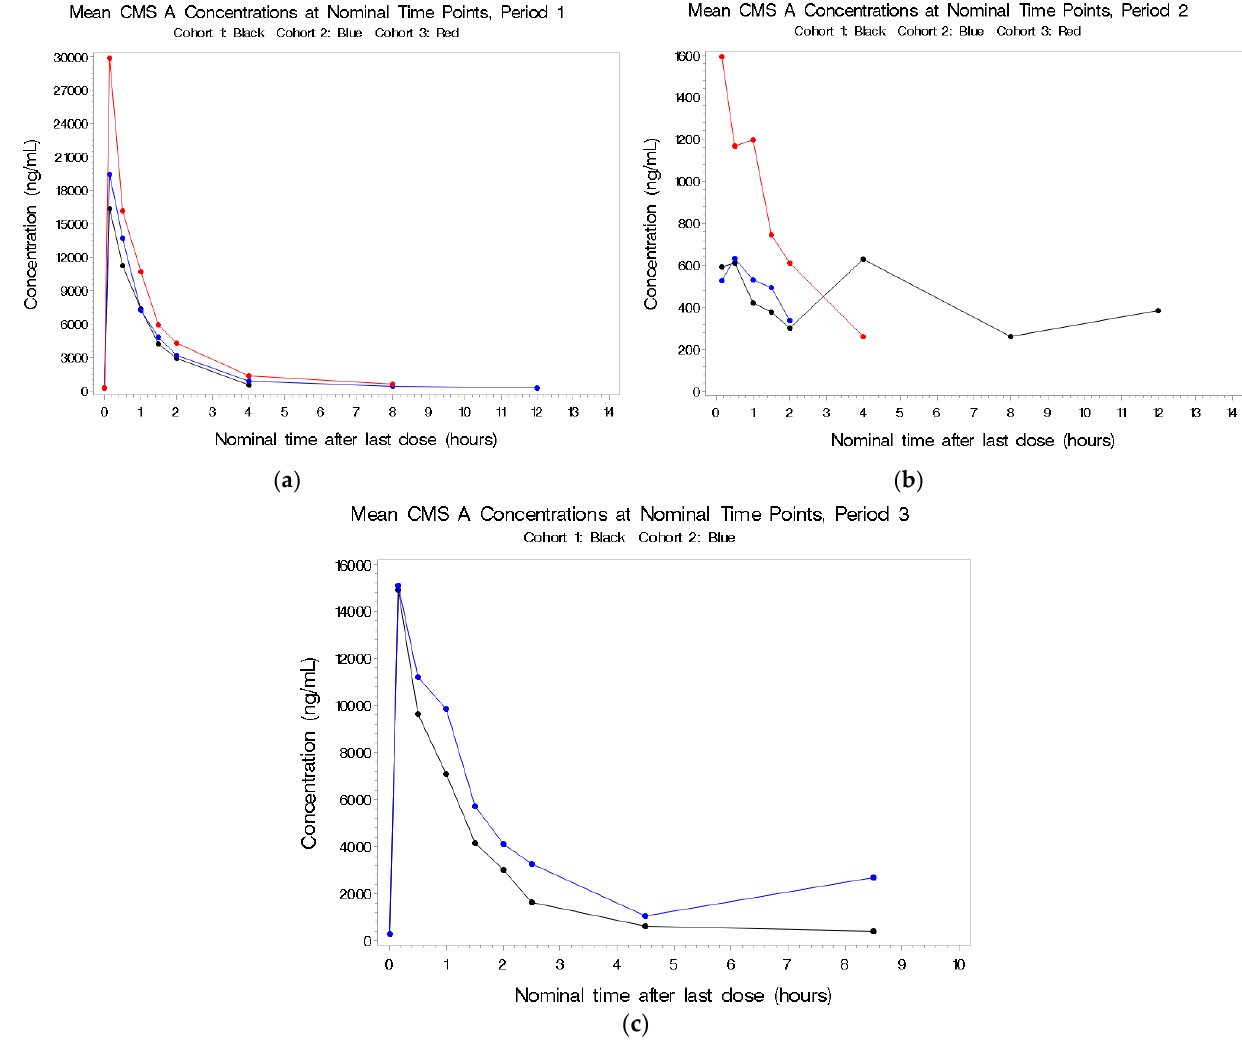
Figure 3. ( a – c ) Mean plasma concentrations for CMS A after last dose in Period 1 by cohort.